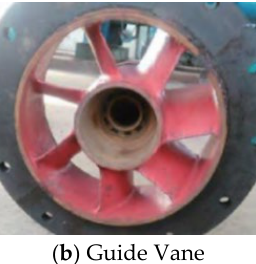
Figure 3. Schematic diagram of the high-precision hydro-mechanical test bench.